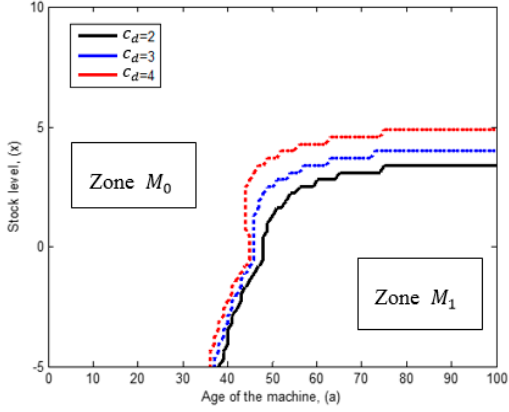
Figure 11. Sensitivity of the defectives cost on the repair/major maintenance policy.